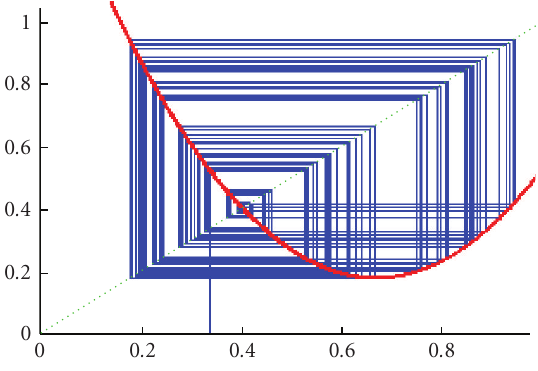
Figure 4.1 . The graph of map f α